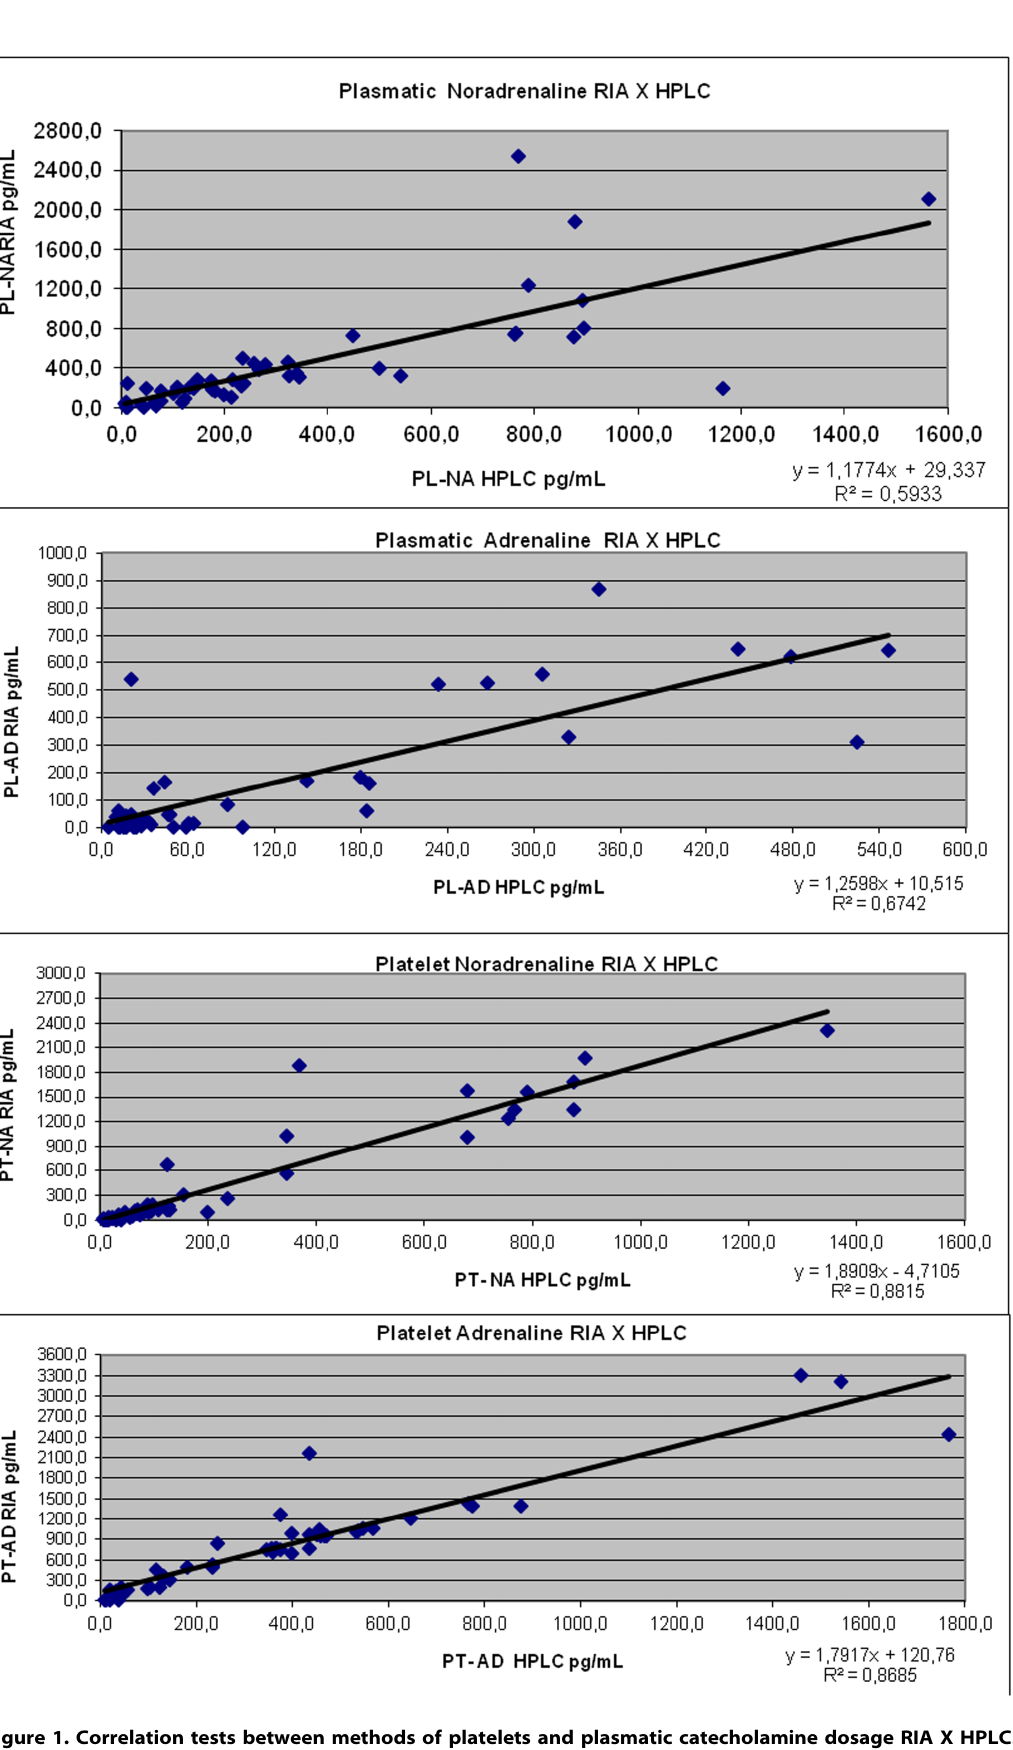
Figure 1. Correlation tests between methods of platelets and plasmatic catecholamine dosage RIA X HPLC. doi:10.1371/journal.pone.0098407.g001 PLOS ONE |